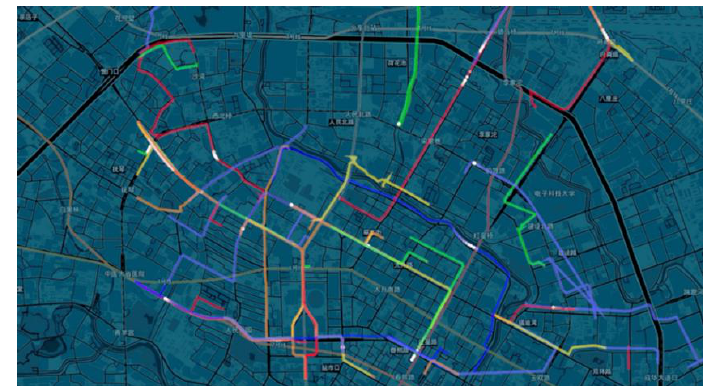
Figure 5. The different GPS tracking of vehicles in Chengdu. Figure 5. The di ff erent GPS tracking of vehicles in Chengdu.